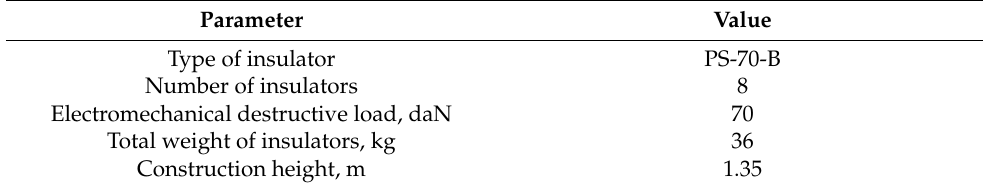
Table 7. Physical and mechanical characteristics of the